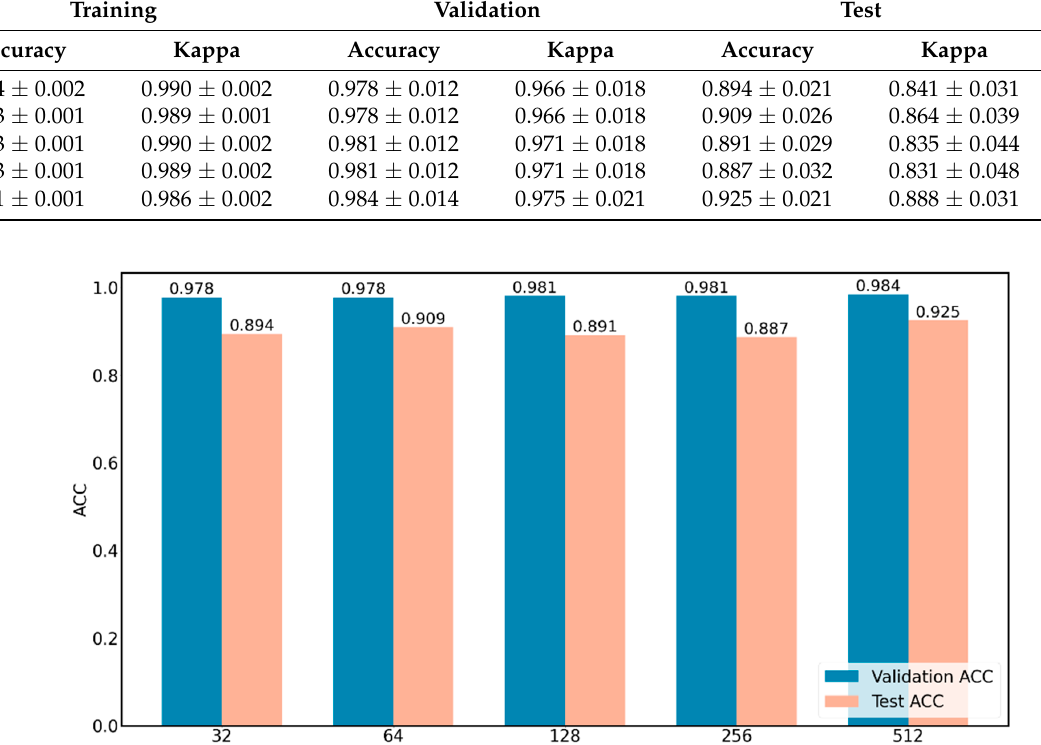
Figure 6. Comparison of performance of parameter optimization of GerdNet-RF classifier. Table 4. Performance evaluation of five feature extraction layers of Gerd-VGGNet.